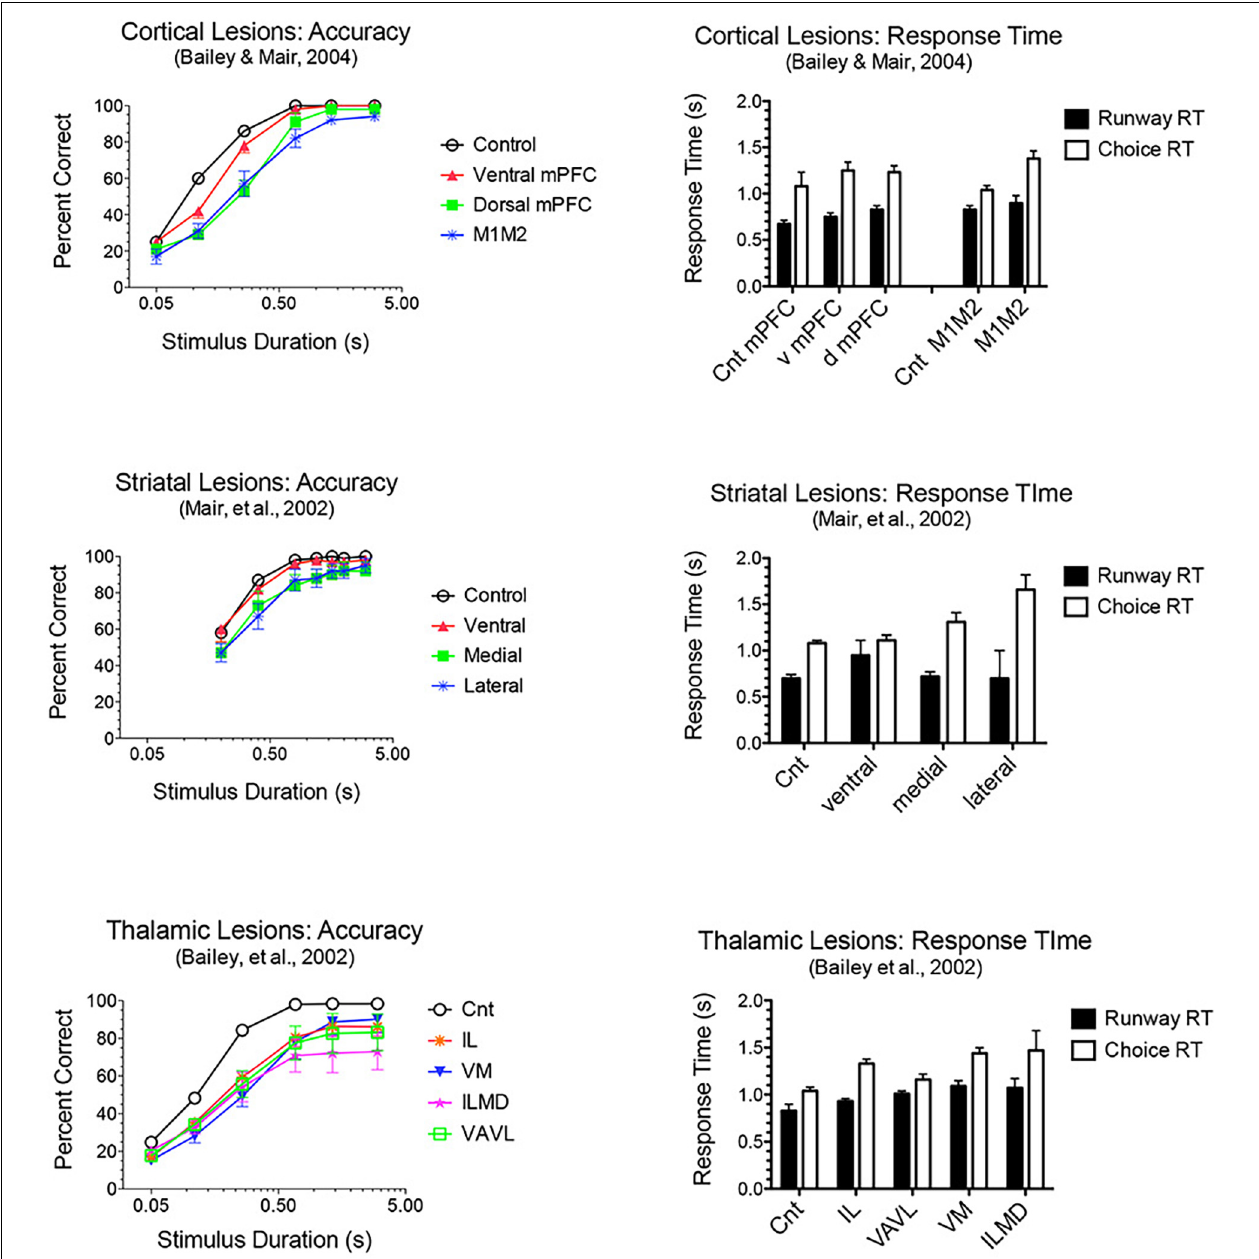
FIGURE 5 | Effects of frontal cortical, striatal and thalamic lesions on visuospatial reaction time (VSRT). Rats performed an observational (runway) response, traveling down a runway after pressing a lever to start the trial, so that they entered the test chamber facing an array of response ports. Entering the test chamber triggered a brief luminance in one of the ports in which water reward was delivered if rats made a nose poke in that port first within a 3.0 s limited hold. Choice accuracy is plotted as a function of stimulus duration (varied randomly from trial to trial). Response time (RT) is plotted for the observational runway response, performed without modification at the start of each trial, and for the stimulus guided choice response. A similar pattern of impairment was observed for lesions of M1M2 motor cortex, dorsolateral striatum, and intralaminar thalamic nuclei (IL): stimulus duration dependent impairment of choice accuracy coupled with an increase in choice, but not runway,